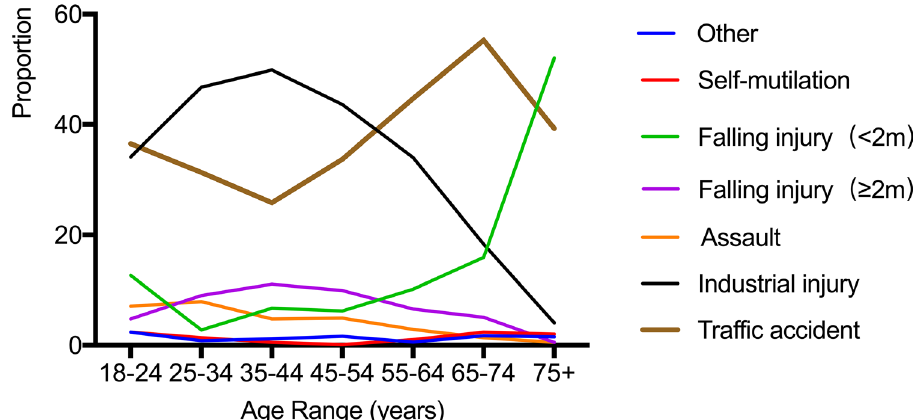
Fig. 2 Trends of injury mecha- nism in different age